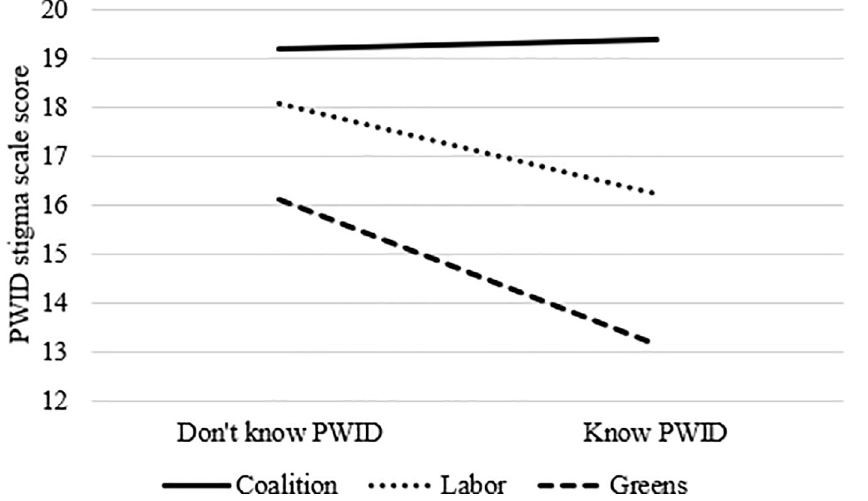
Fig 1. Interaction effect between political conservativism and knowing people who inject